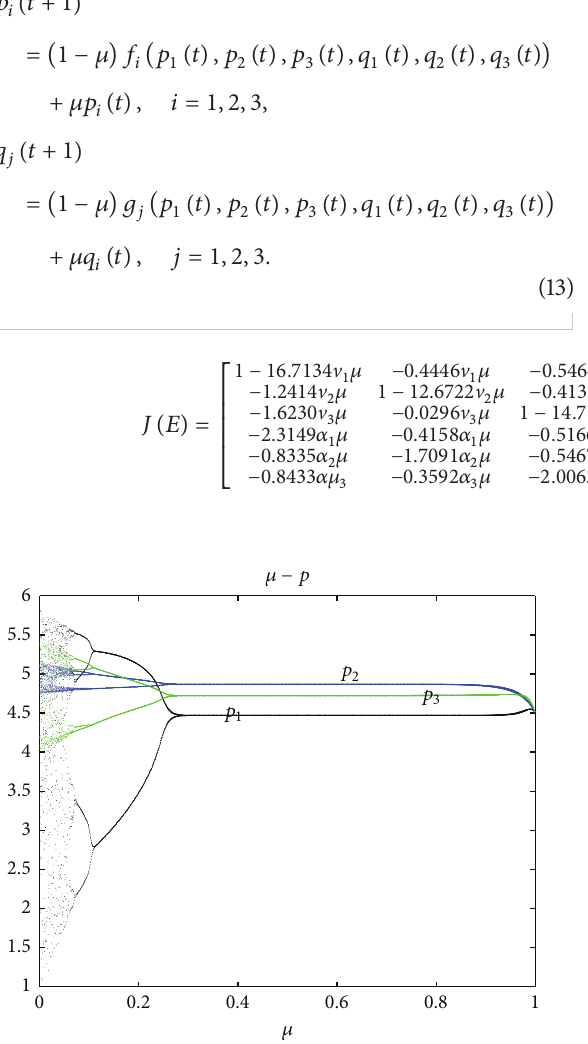
𝑞 𝜇 𝑖 with parameter